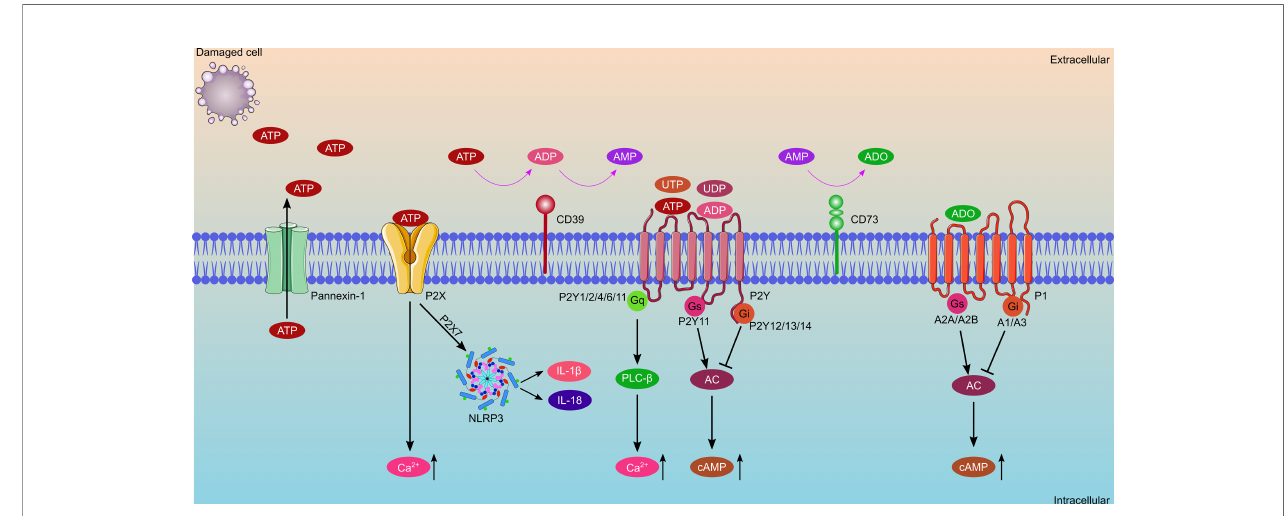
FIGURE 2 | Schematic diagram of purinergic signaling components, which consist of extracellular nucleotides and nucleosides, ecto-enzymes, and cell surface receptors. ATP is released from damaged cells or through the Pannexin-1 channel, and then is rapidly dephosphorylated to ADP and AMP by CD39, with AMP further catalyzed to adenosine by CD73. Purinergic receptors consist of P1 receptors and P2 receptors. P1 receptors bind with adenosine, which consist of A1, A2A, A2B and A3 receptors. A1Rs and A3Rs are coupled with Gi proteins and inhibit adenylate cyclase, whereas A2ARs and A2BRs coupled with Gs proteins and stimulate adenylate cyclase. P2 receptors consist of P2X and P2Y receptors, of which, P2XRs bind with ATP only, while P2YRs can bind with ATP, ADP, UTP, and UDP. Activation of P2XRs increases the concentration of intracellular Ca 2+ . Activation of P2YRs causes a change in the concentration of intracellular Ca 2+ or